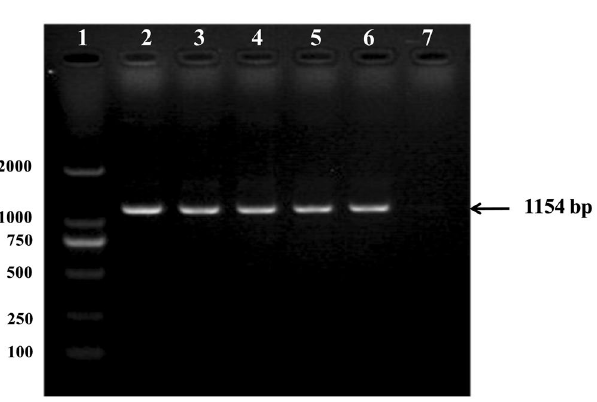
Figure 2. Standard curves of formononetin and isoliquiritigenin determined by HPLC.